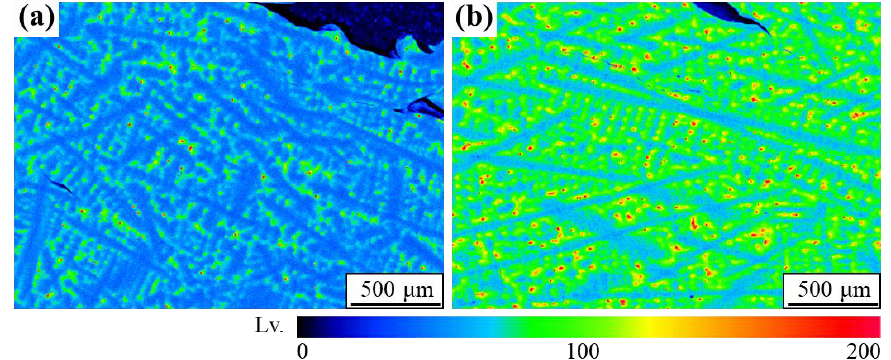
Figure 5. EPMA vanadium maps of the cross-section of the fractured specimen at T T = 800 °C; ( a ) Steel A, ( b ) Steel B.